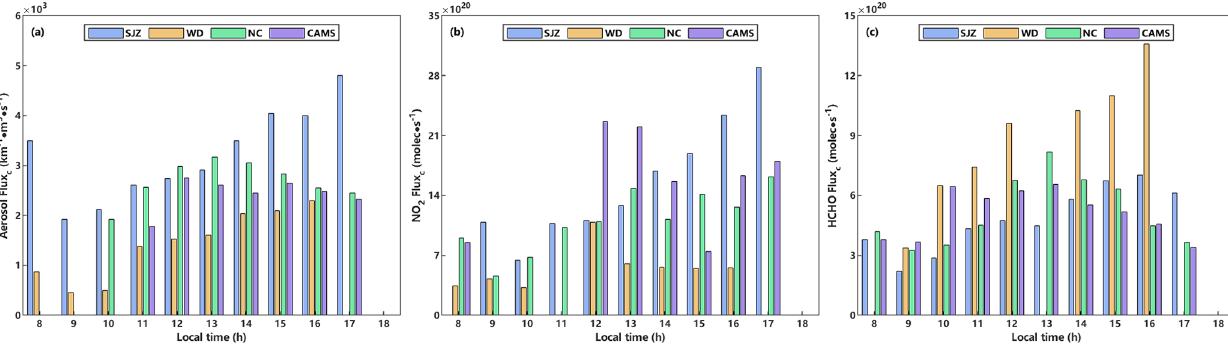
as pre-comparison (PRE), and we defined the comparison be- tween 15 and 22 March 2021 as post-comparison